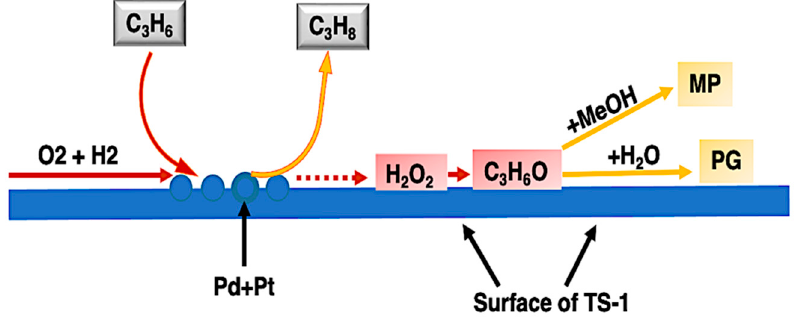
Figure 8. Illustrative scheme of a one-pot green route to produce propylene oxide catalyzed by 0.2% Pd-0.02% Pt catalyst supported over TS-1 zeolite using liquid or supercritical carbon dioxide as a solvent.